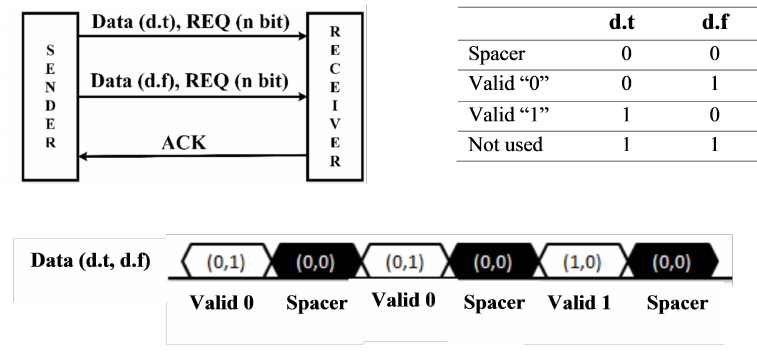
Figure 6. Dual-rail encoding